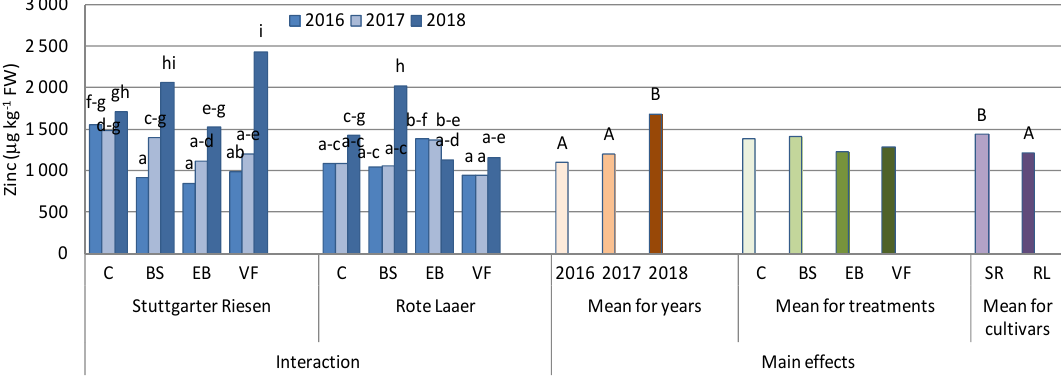
Figure 5. Zinc content in onion bulbs depending on the cultivar, treatments, and years of investigation. The data give the mean values of four replications. Di ff erent letters denote significant di ff erences: lowercase letters refer to the interaction and capital letters to the main e ff ects (Fisher’s test, p ≤ 0.05). Abbreviations: C—control; BS—B-Stimul; EB—EkoBooster 2; VF—VermiFit A; SR— Stuttgarter Riesen; RL—Rote Laaer.